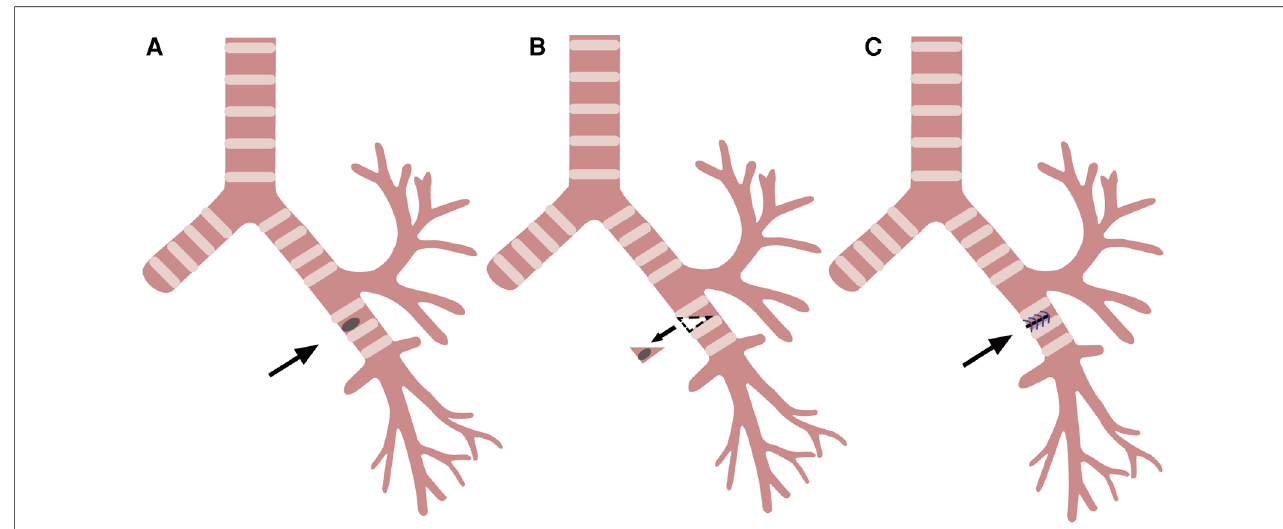
FIGURE 2 Wedge resection and reconstruction of the bronchi. ( A ) Left main bronchus tumor (arrow). ( B ) Resection of the tumor along the dotted line (arrow). ( C ) Left main bronchus wall after suture